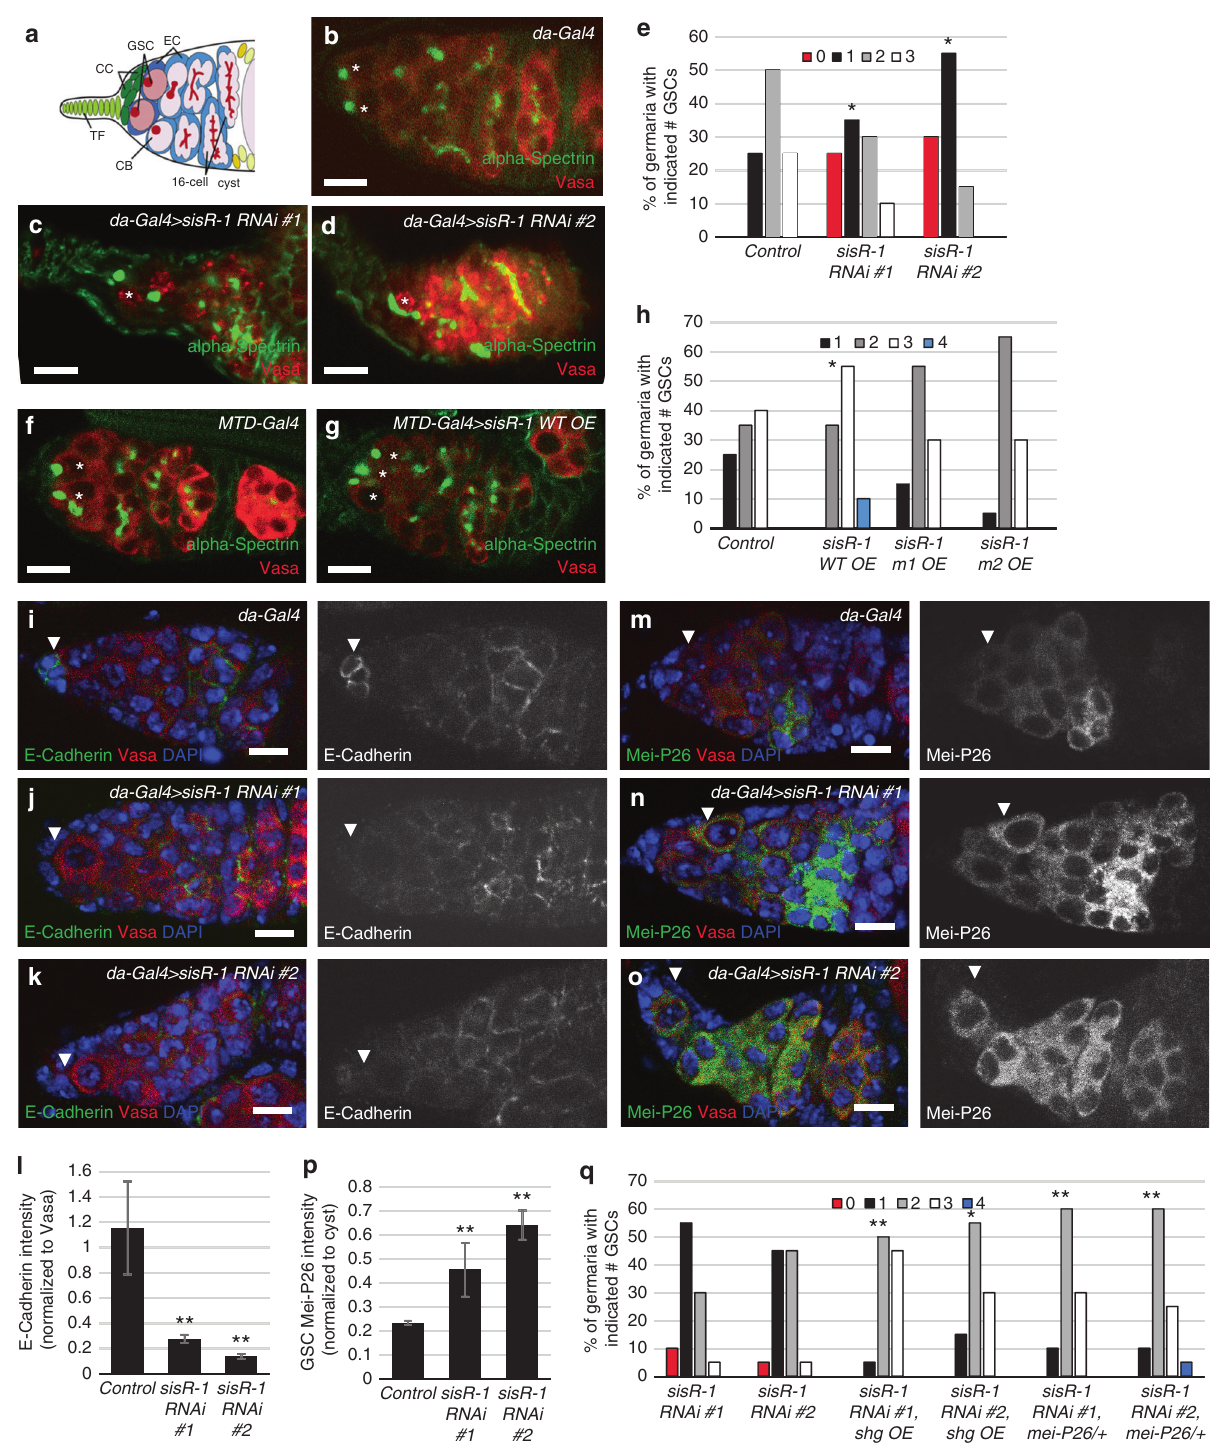
Fig. 2 s isR-1 regulates GSC – niche occupancy by maintaining GSC – niche adhesion and suppressing GSC differentiation. a A drawing of a germarium. GSC, germline stem cell, CC, cap cell, TF, terminal fi lament, EC, escort cell, CB, cystoblast. b – d , f – g Confocal images of germaria of the indicated genotypes stained for alpha-Spectrin ( green ) and Vasa ( red ). Scale bar : 10 µ M. Asterisks (*) mark the GSCs. e , h , q Charts showing the percentages of germaria with the indicated number of GSCs of the indicated genotypes. * P < 0.05, ** P < 0.01. Fisher ’ s exact test. N = 20. i – k Confocal images of germaria of the indicated genotypes stained for E-Cadherin ( green ), Vasa ( red ), and DAPI ( blue ). Arrowheads point to GSC – niche interfaces. m – o Confocal images of germaria of the indicated genotypes stained for Mei-P26 ( green ), Vasa ( red ), and DAPI ( blue ). Scale bar , 10 µ M. Arrowheads point to GSCs. l , p Charts showing the quanti fi cation of E-Cadherin and Mei-P26 intensities. ** P < 0.01. N = 3. Error bars represent